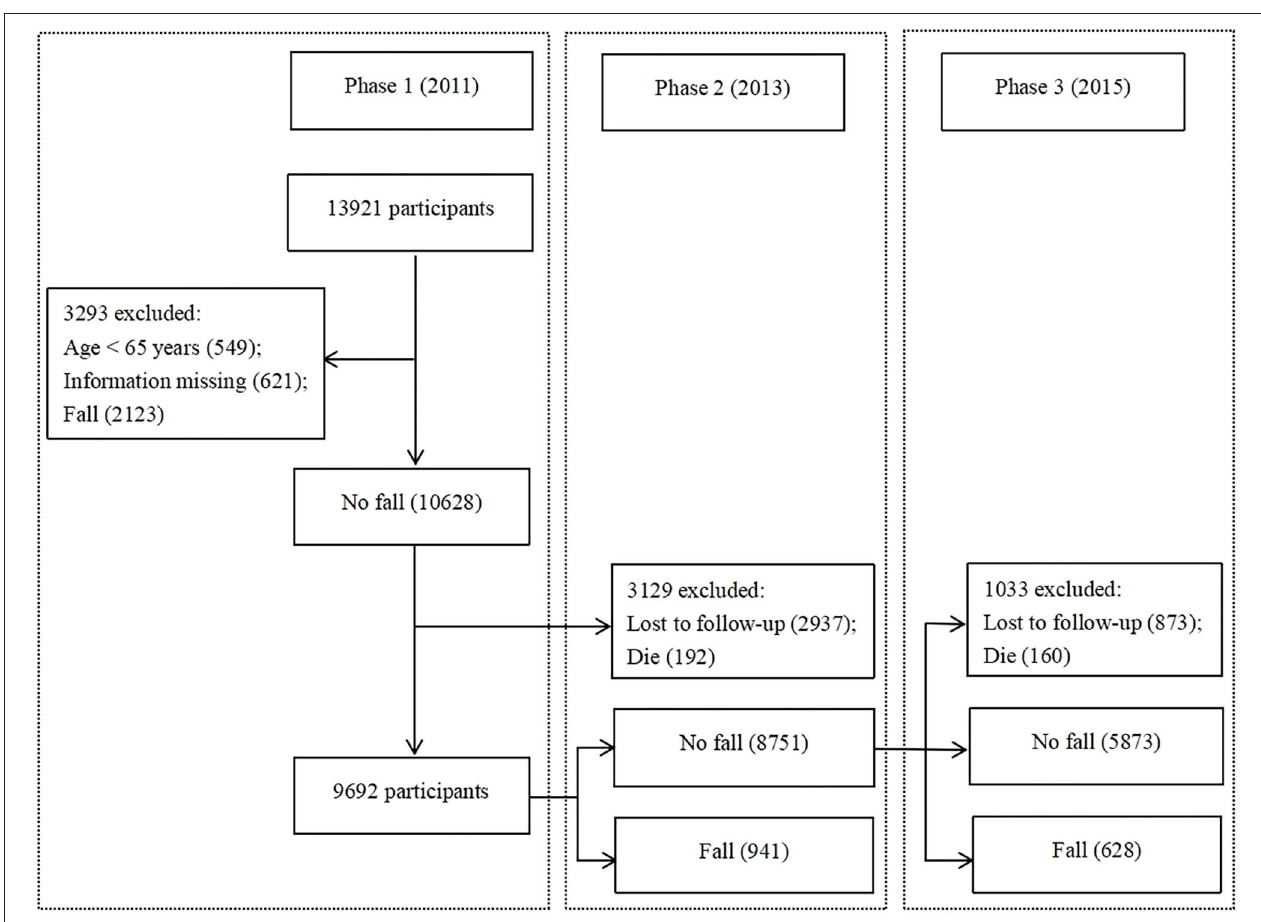
FIGURE 1 | Flow chart of participant